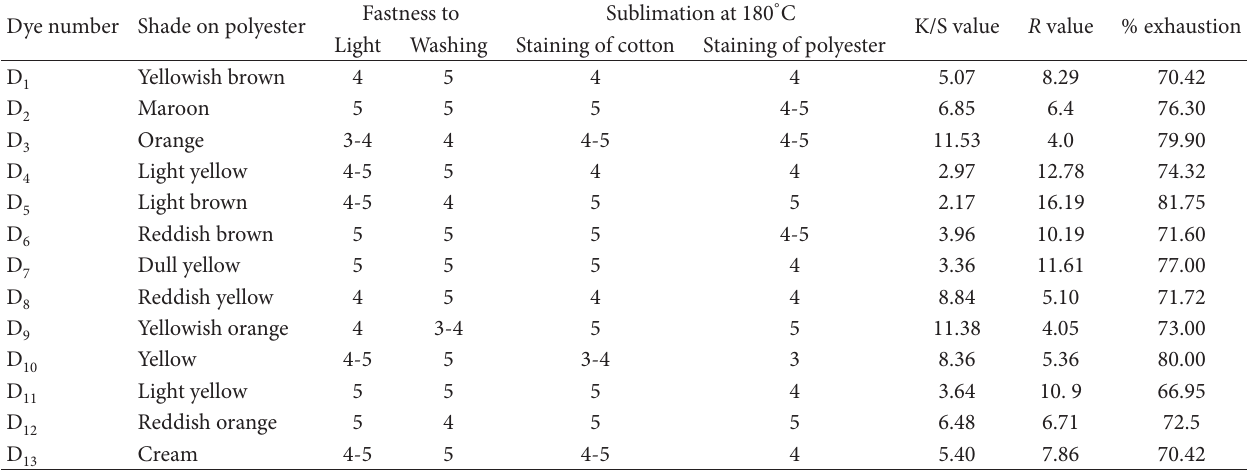
T 2: Shade, fastness properties, K/S value, R value, and